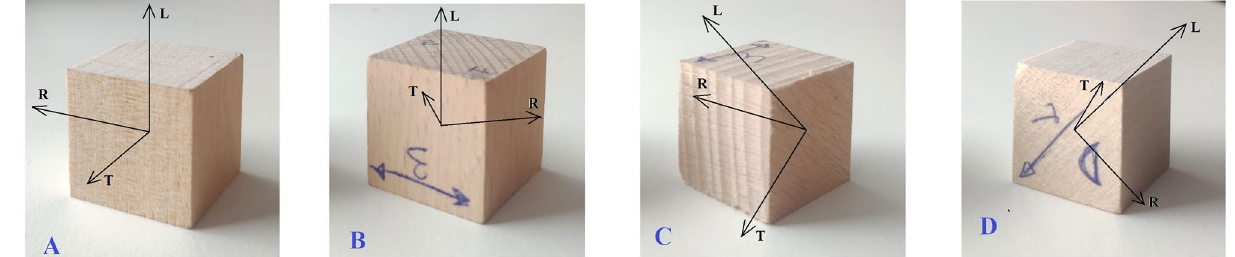
Figure 3. Specimens used for ultrasound measurements with different